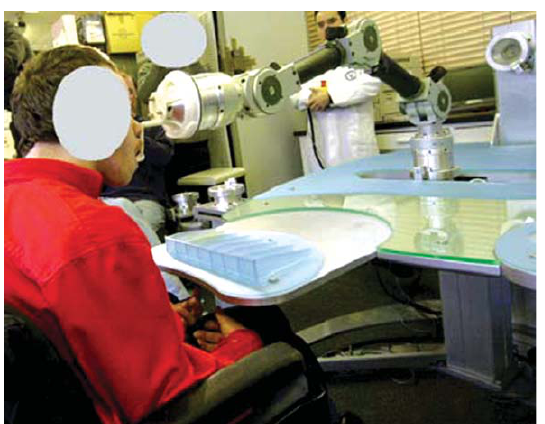
Fig. 1. Robot image in feeding operation.